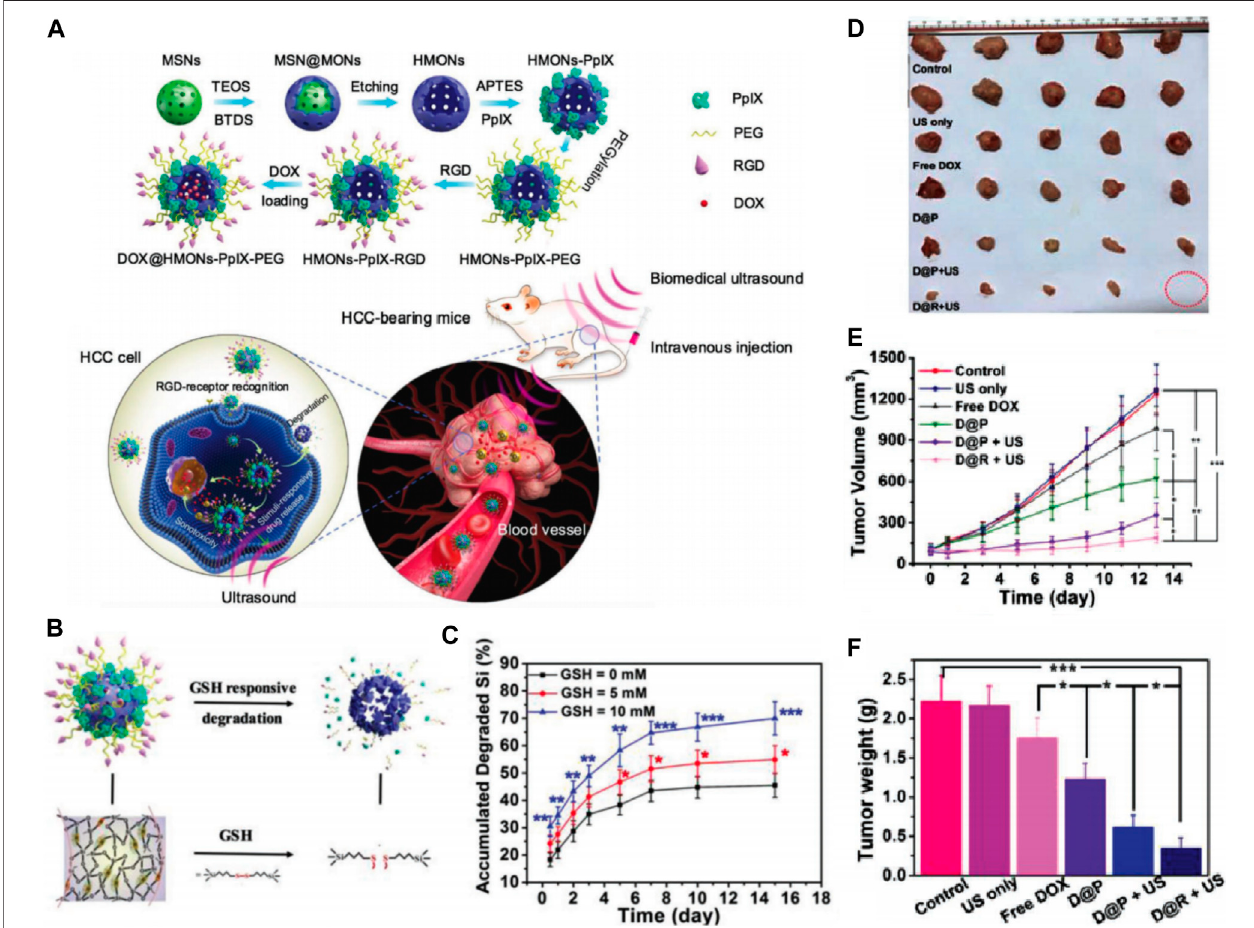
FIGURE11|(A) SchematicillustrationofthesyntheticprocessofHMONs-PpIX-RGDandsynergisticchemo-SDTagainstHCCtumorxenograftonnudemice. (B) Schematic illustration of microstructure and corresponding biodegradation induced by breaking up of physiologically active disul fi de bond within the framework of HMONs-PpIX-RGD. (C) ThecorrespondingamountofdegradedSicomponentduring15 days observation. Invivo synergisticchemotherapy-SDTagainst HCCtumor- bearing mice: (D) Ex vivo tumor images of different treated groups as indicated. (E) time-dependent tumor growth curves after different treatments and (F) tumor weights of mice on the 15th day after the treatments. Reprinted with permission from Li et al. (2018). Copyright (2018) John Wiley and Sons.